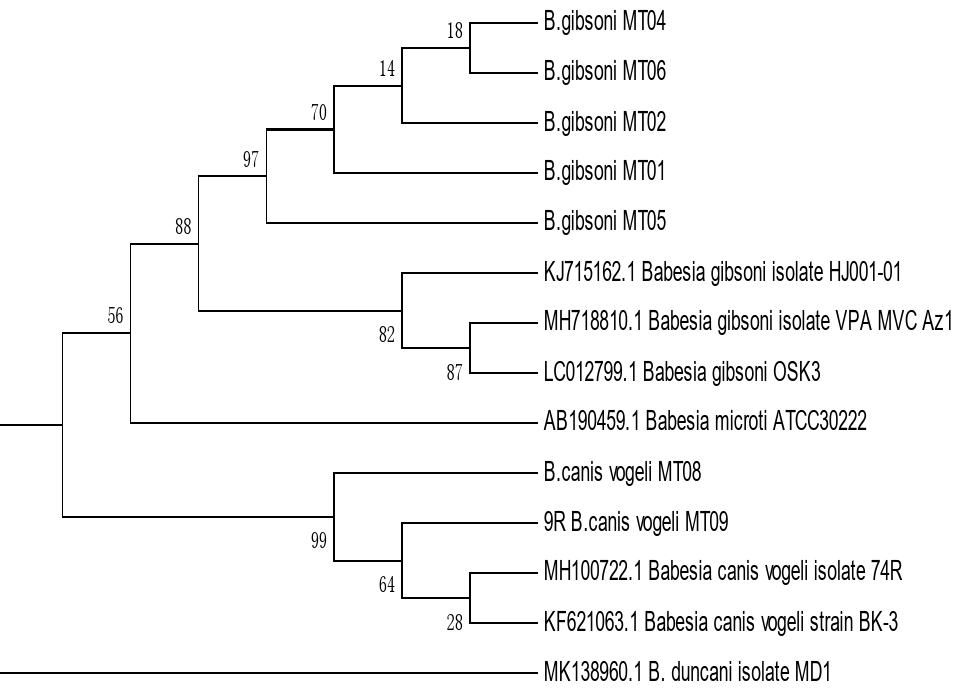
Figure 2. An ethidium bromide-stained agarose gel of the PCR products from species-specific nested PCR of Babesia infected dog blood samples. Lane M shows a DNA marker. Lanes from “A” to “C” are samples from naturally infected dogs showing a band of 267 bps.